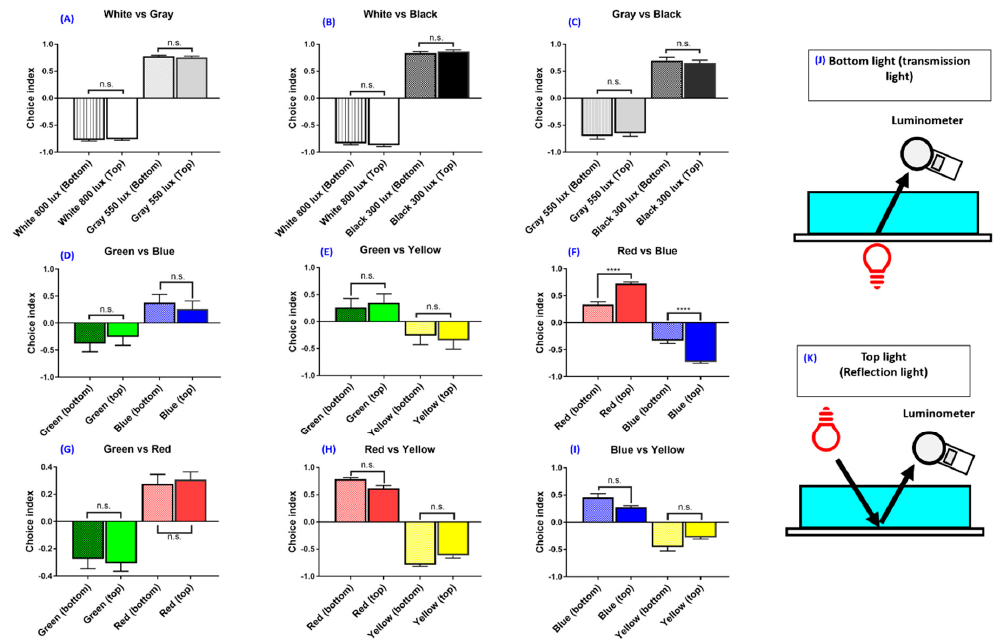
Figure 2. The e ff ect of light intensity and light source position on the zebrafish swimming activity choice index. ( A – C ) The e ff ect of di ff erent light intensity on the zebrafish swimming activity choice index. ( A ) White and grey combination, ( B ) white and black combination, ( C ) grey and black combination. ( D – I ) The e ff ect of di ff erent color and light position on the zebrafish swimming activity choice index. ( D ) Green vs. blue combination, ( E ) green vs. yellow combination, ( F ) red vs. blue combination, ( G ) green vs. red combination, ( H ) red vs. yellow combination, ( I ) blue vs. yellow combination. ( J , K ) Schematic showing the light source positions either from the bottom or on top. The light intensity was measured by using a luminometer. The data are presented as mean ± SEM, n = 24 for each group. The di ff erence was tested by one-way ANOVA and the significance level was set at, **** p < 0.0001. n.s. = non-significant.